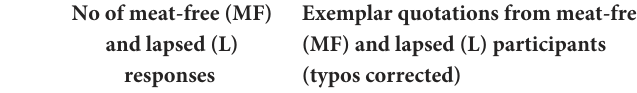
Exemplar quotations from meat-free and lapsed (L) (MF) and lapsed (L) participants responses (typos